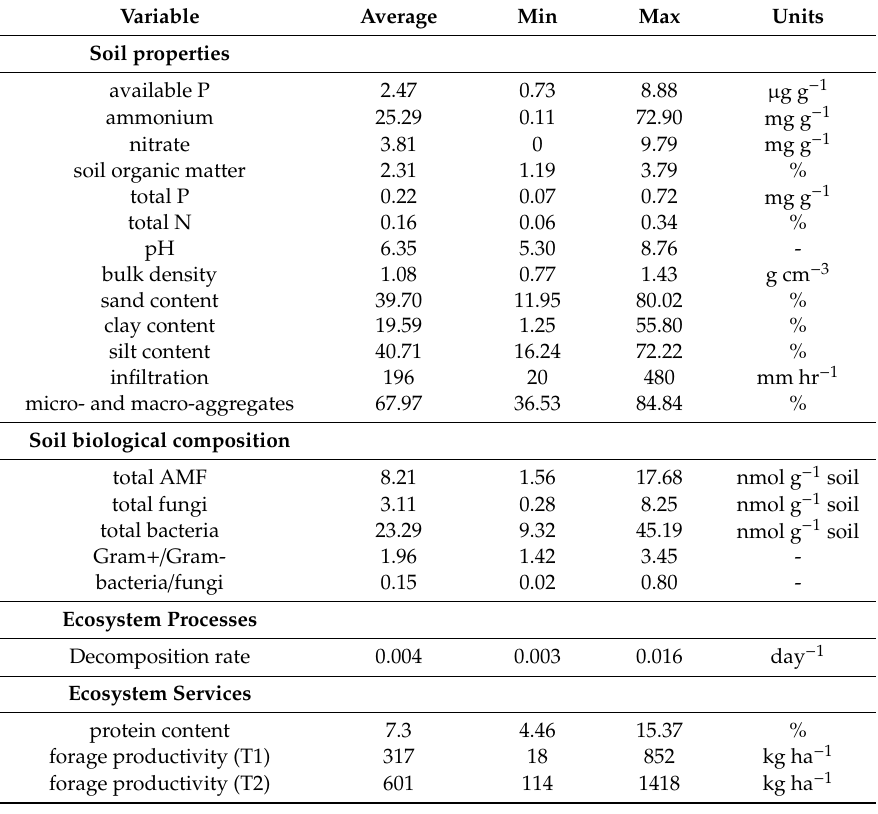
Table 2. Soil chemical and physical properties, decomposition rate, and provisioning ecosystem services variables tested in the model, their average, maximum and minimum values for 31 study